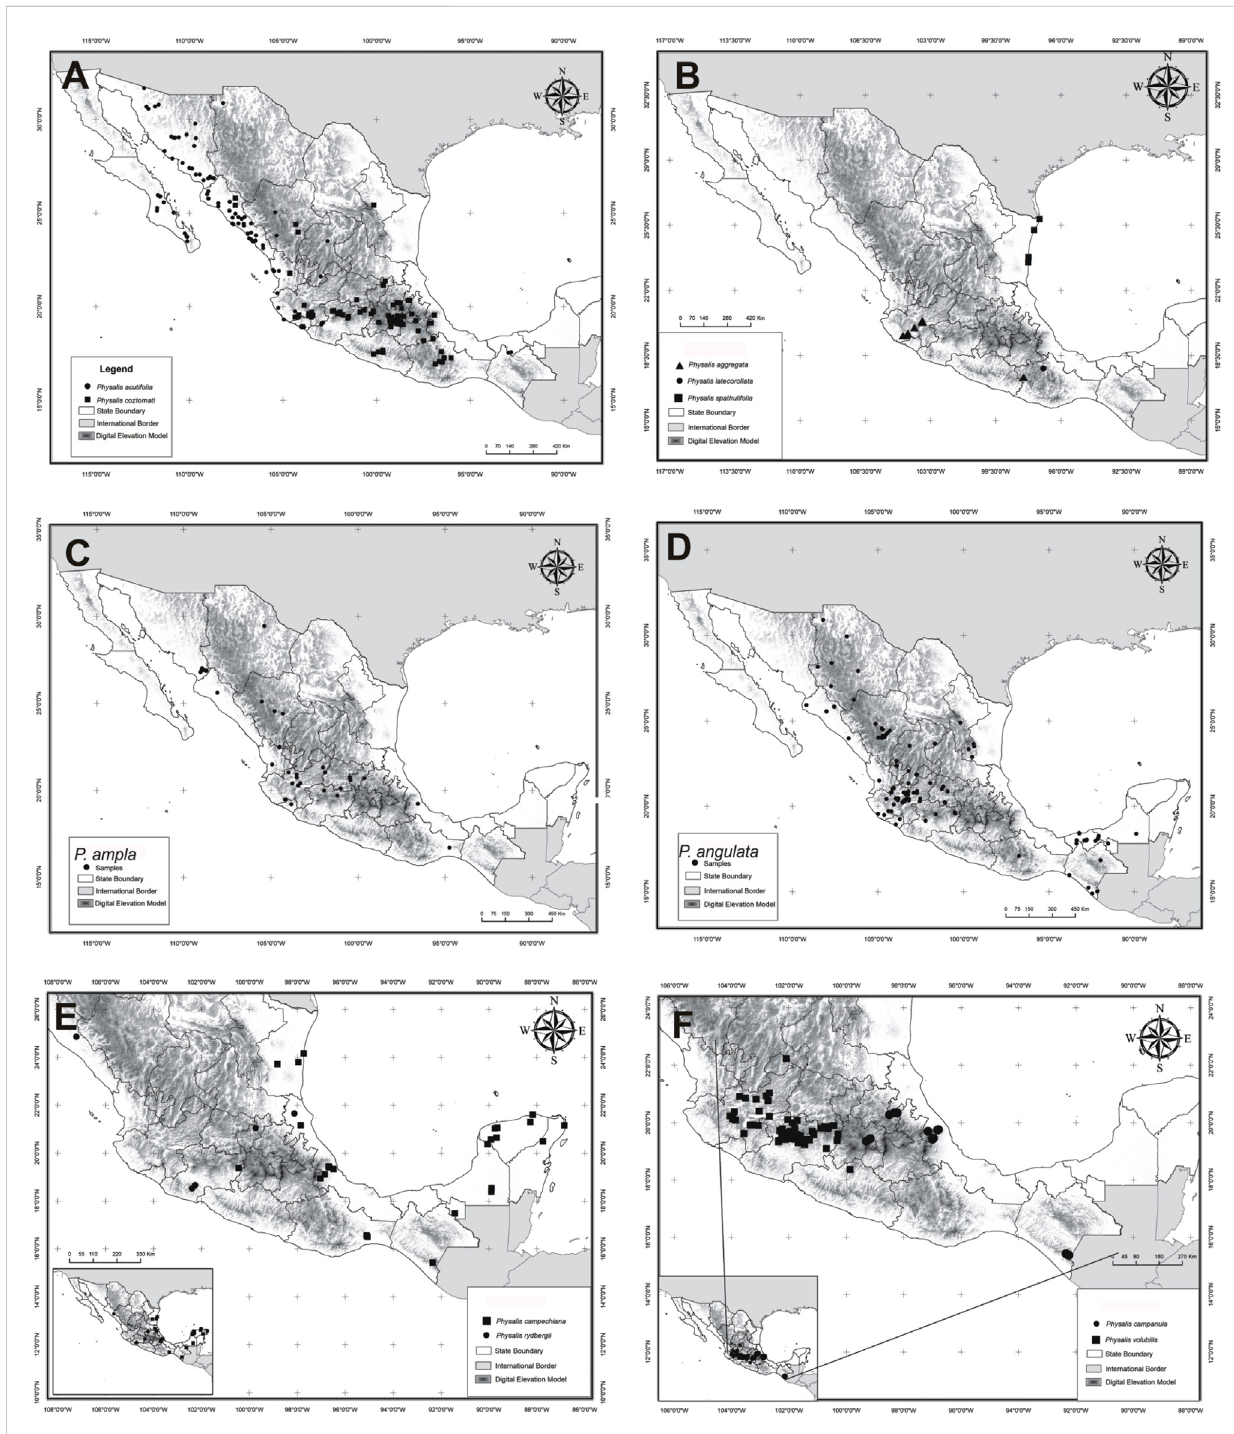
Geographic distribution of Physalis spp. (A) P. acutifolia and P. coztomatl ; (B) P. aggregata , P. latecorollata , and P. spathulifolia ; (C) P. ampla ; (D) P. angulata ; (E) P. campechiana and P. rydbergii ; (F) P. campanula and P.